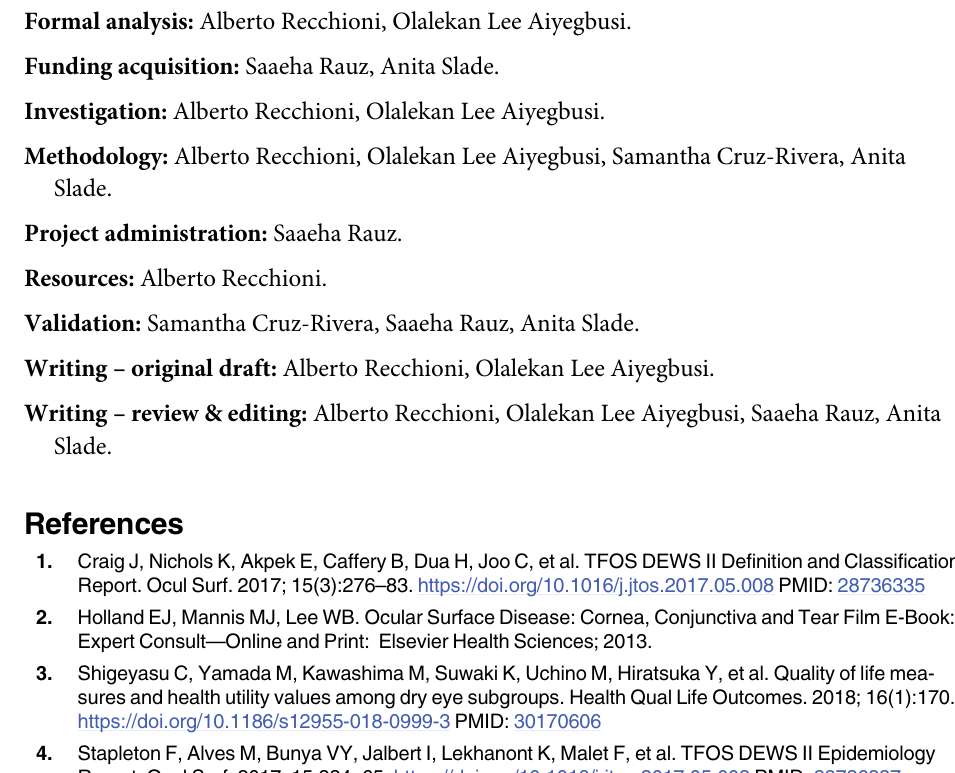
S1 Table. COSMIN definitions of domains, measurement properties, and aspects of mea- surement properties. S2 Table. S2 Table summary of FDA PRO requirements. S3 Table. Search strategy proms in dry eye disease and ocular surface